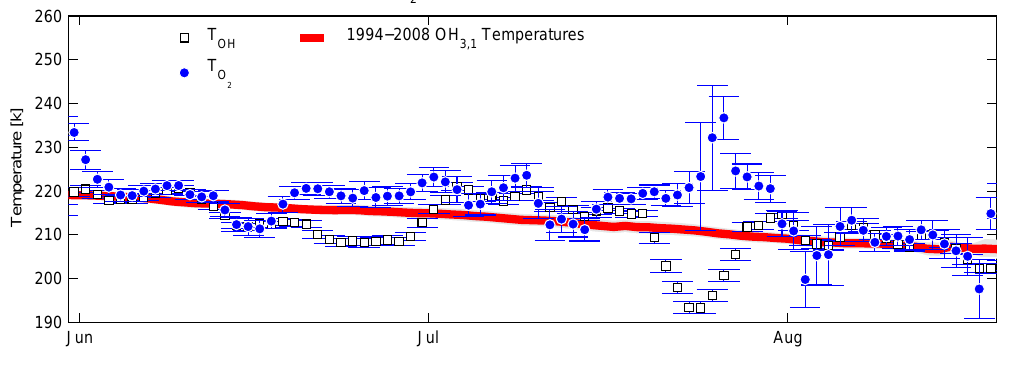
Fig. 5. 5-day smoothed OH (square) and O 2 (filled circle) rotational temperatures at South Pole during 2002. The climatological mean of OH(3,1) rotational temperatures is shown in red for reference. Mesospheric cooling and lower thermospheric warming can be noted in OH and O 2 rotational temperature data,